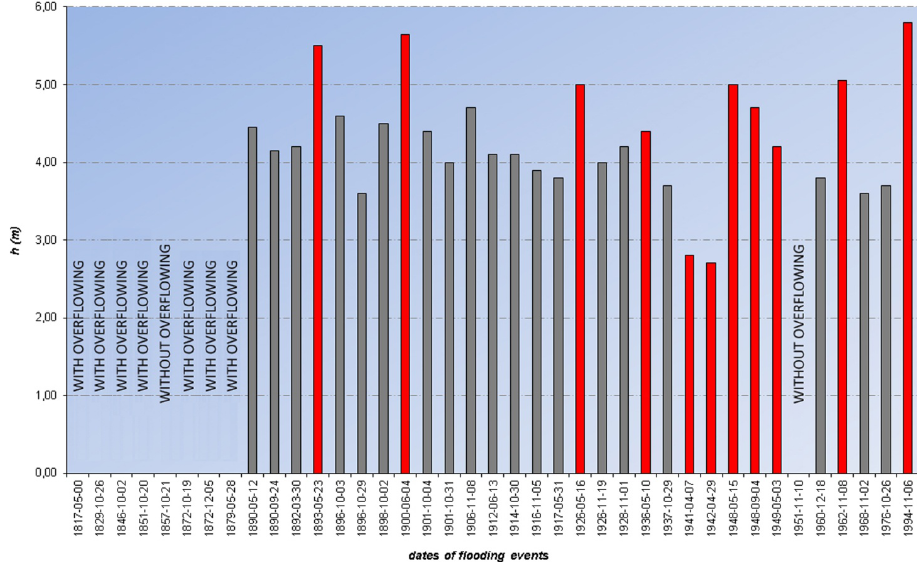
Fig. 7 – Tanaro floods during the period 1801-2000 with related hydrometric heights (m above gauge datum equivalent to 183.86 m a.s.l.) measured at the Pollenzo station. Floods causing damage in the Alba area are indicated in red. Floods without hydrometric values are labeled “without overflowing” (no damage) or “with overflowing” (damage). Tab. I - Main effects and damage caused by floods of the Tanaro and its tributaries in different areas of Alba during the period 1801- 2000. Date of the flood